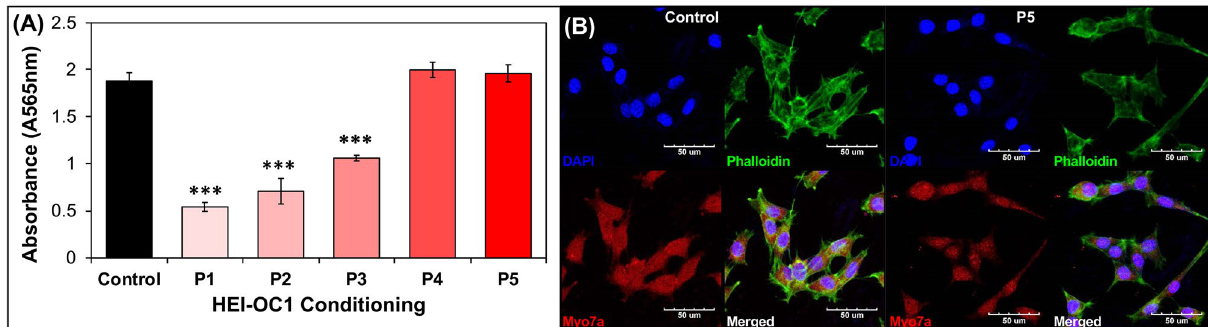
Figure 1. HEI-OC1 cell conditioning for co-culture. HEI-OC1 cells were cultured in stem cell media at 37 °C and passaged five times prior to co-culture. ( A ) MTT assay showed a decrease in cell proliferation at the start of conditioning. Proliferation of conditioned HEI-OC1 cells normalized with the control after the fourth passage. ( B ) Confocal images of HEI-OC1 cells before (Control) and after conditioning (P5); expression of f-actin and Myo7a was observed at both time points. Scale bars represent 50